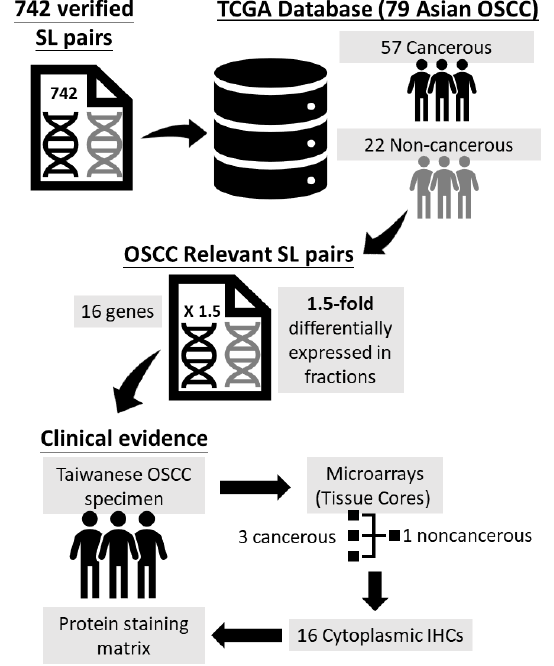
Figure 1. Schematic diagram for target gene selection from the validated synthetic lethality (SL) gene pairs and the identification of the protein staining matrix. Table 1. The antibodies and retrieval buffers for each protein.